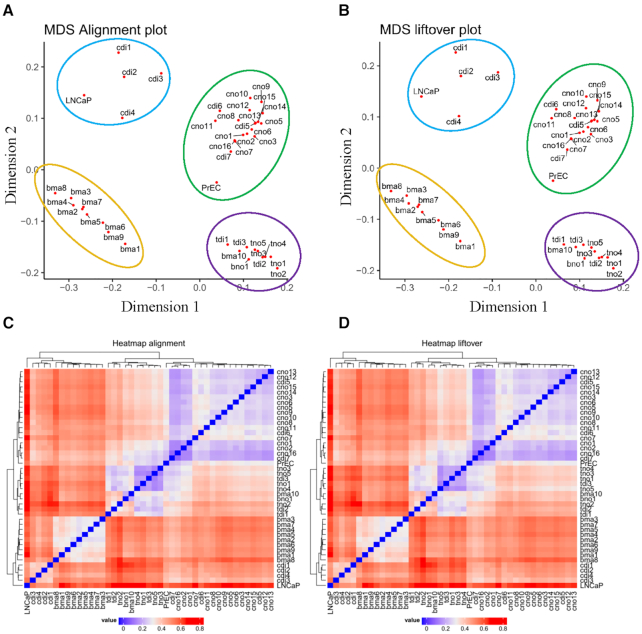
Liftover maintains DNA methylation signature of cell type specificity. (A) MDS of 43 alignment methylomes. (B) MDS of 43 liftover methylomes. (C) Unsupervised hierarchical clustering of 43 alignment methylomes. (D) Unsupervised hierarchical clustering of 43 liftover methylomes.